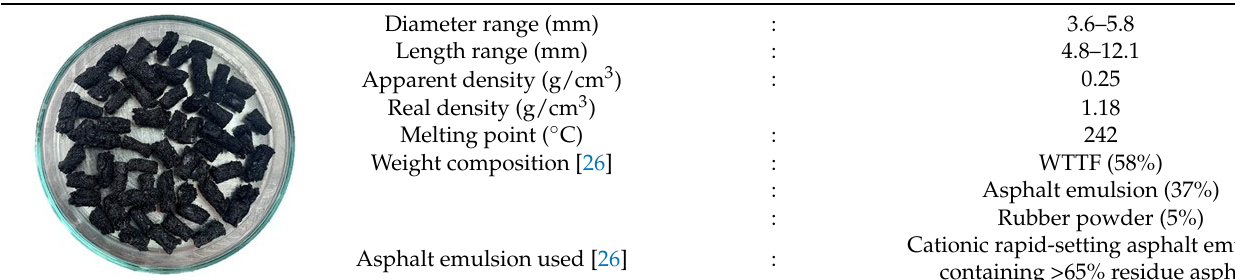
Table 1. Characterization of the WTTF-based additive.